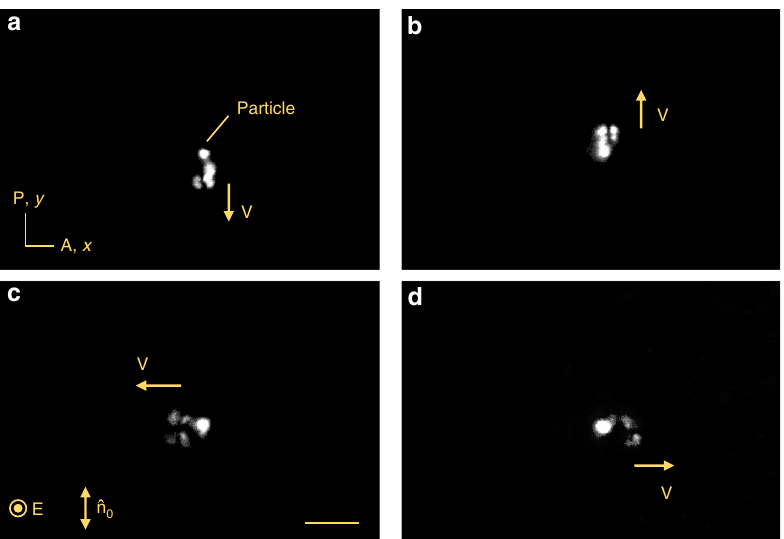
and B l solitons at the same dust particle. The solitons B l Fig. 3 Nucleation of B l 0 90 nucleate and move c left and d right, perpendicularly to the background director. Temperature 55 °C; applied voltage 9.0 V, frequency The solitons B l 90 20 Hz, scale bar 30 µ m